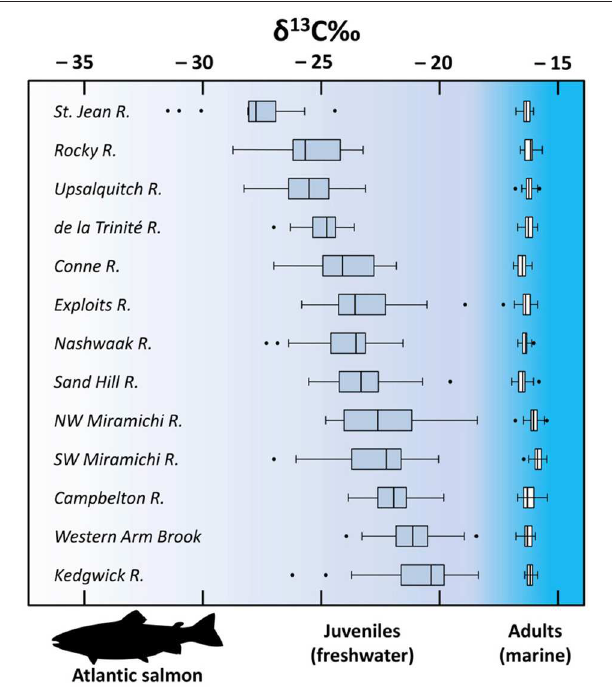
FIGURE 5 | Box and dot plots showing mean δ 13 C for Atlantic salmon scale collagen from freshwater juveniles (left) and adults (right; after first winter at sea) that are departing and returning to their natal rivers, respectively, across eastern Canada between 2009 and 2010. For all samples n = 30, except for de la Trinité (22 juveniles; 19 adults), Exploits (21 adults), NW Miramichi (29 adults). Note the contrast between the extreme range of variation for smolts and how, after 1 year at sea, adults of the same population become comparatively homogenous. Data from Dixon et al. (2012).